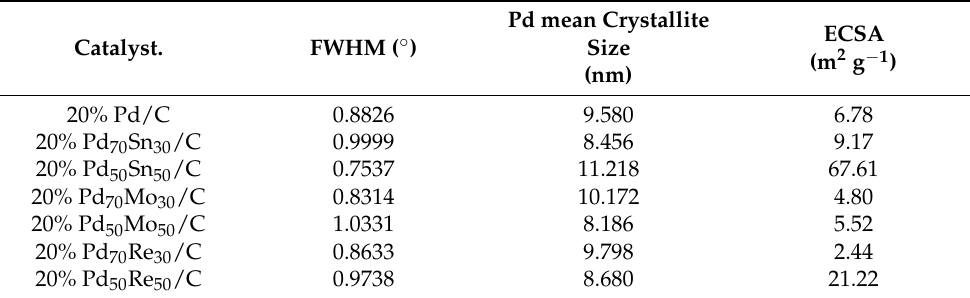
Table 1. Crystallite size obtained from X-ray diffraction analyses and electrochemical surface area (ECSA) obtained from electrochemical measurements.